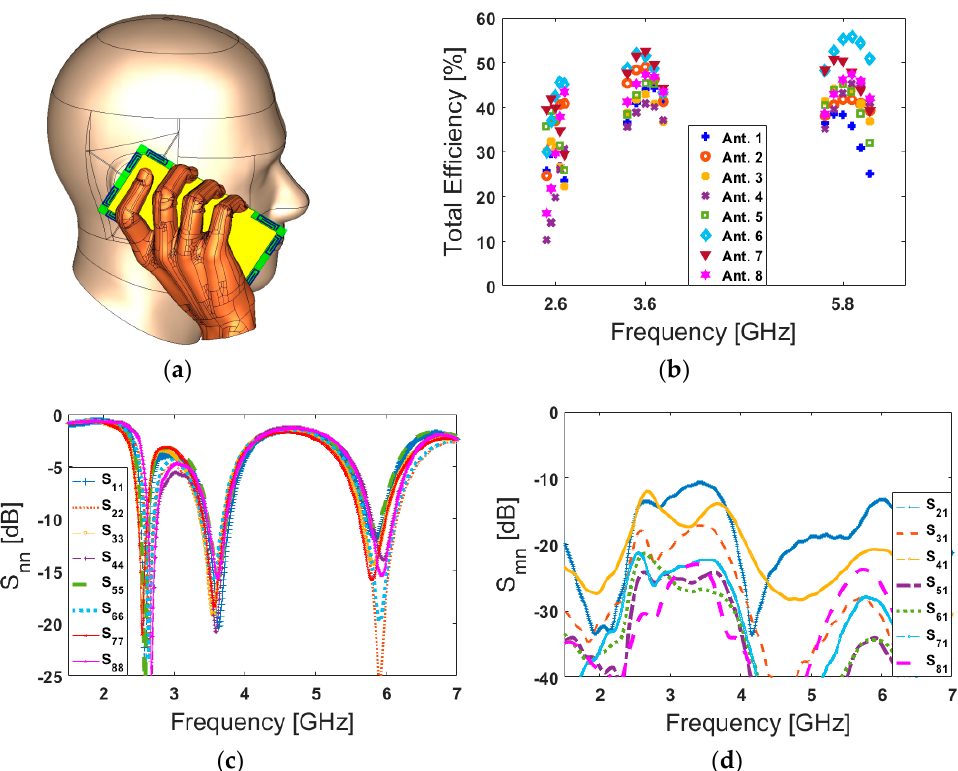
Figure 16. ( a ) Placement, ( b ) total efficiencies, ( c ) S nn , and ( d ) S mn results for the talk-mode scenario.